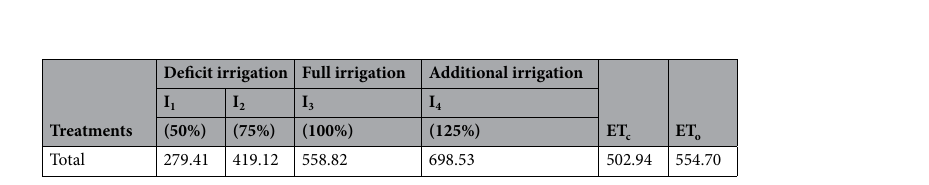
Table 4. Irrigation amounts and ET o (mm), during 2017 growing seasons. ET o : reference evapotranspiration.